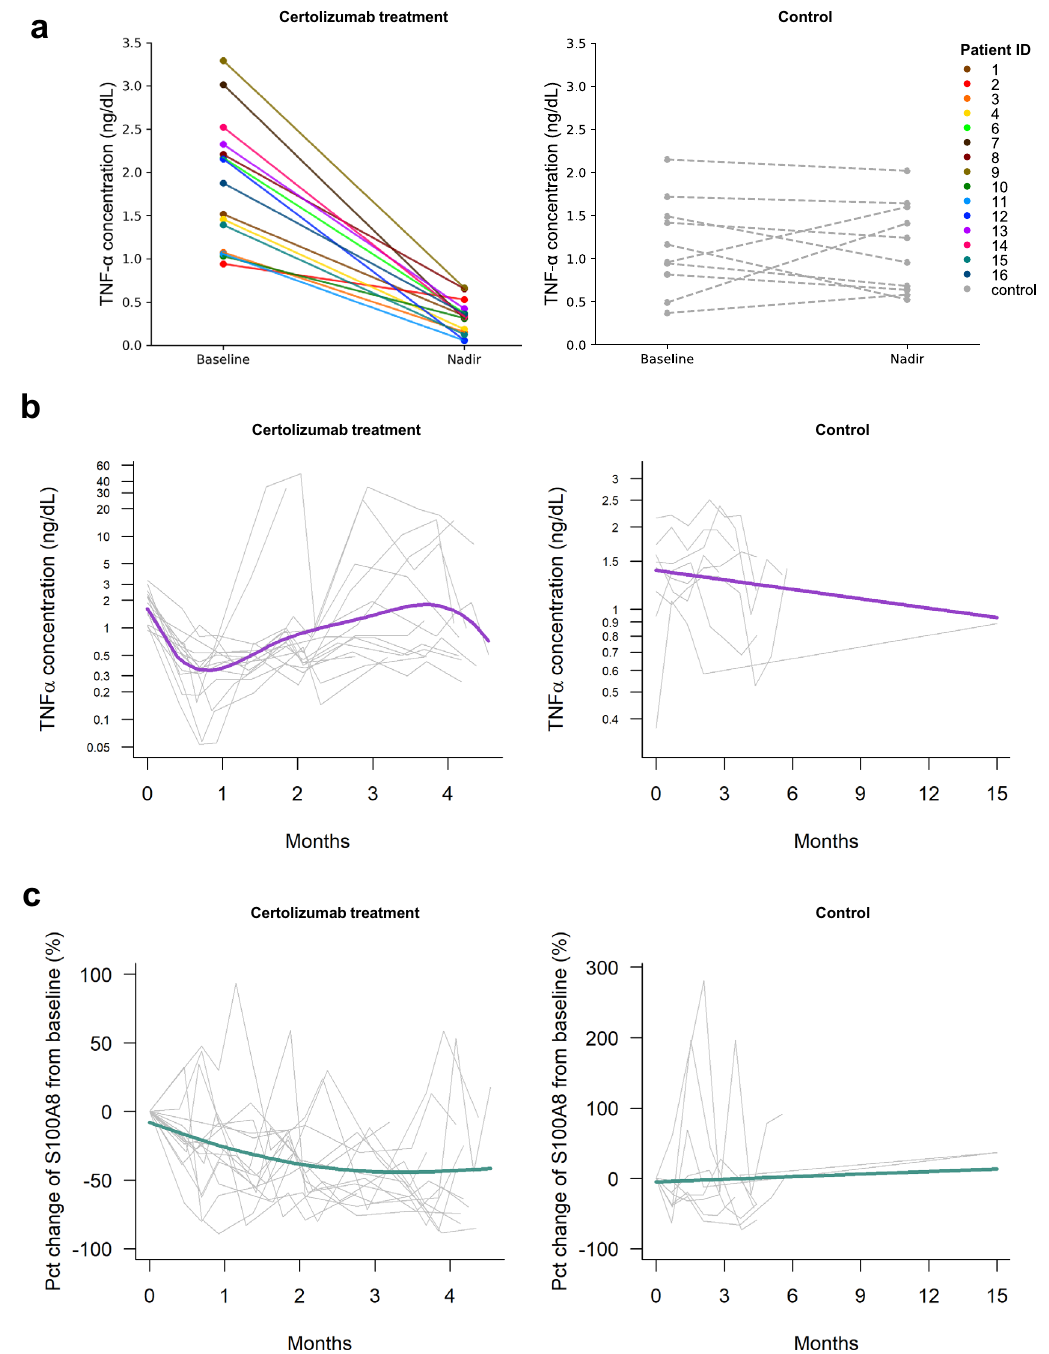
Fig.3|LongitudinalTNF- α andS100A8concentrationsduringtherapy.a Trend plots depicting changes in TNF- α concentration from baseline to nadir during the course of therapy for patients ( n =15) treated with cisplatin, pemetrexed, and certolizumab (left panel) and contemporaneous control patients ( n =10) treated with platinum plus pemetrexed chemotherapy (right panel). b Plots showing